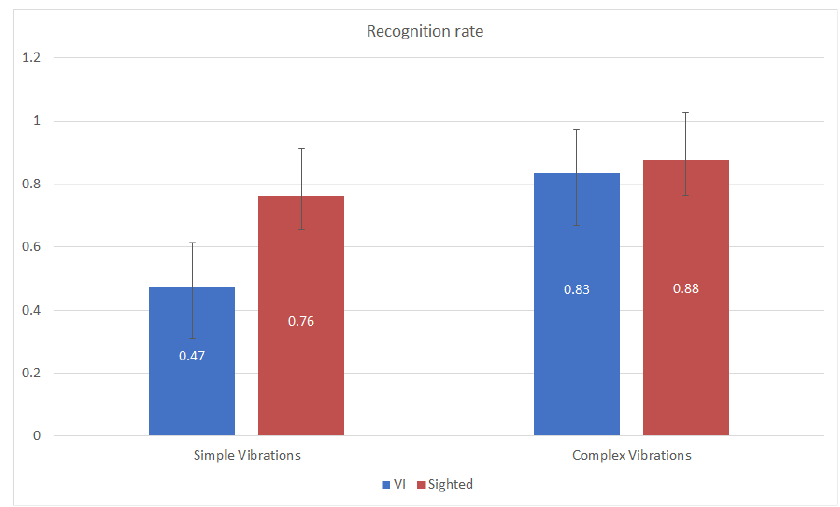
Figure 5. Application recognition rate. For all the subjects, this figure shows the recognition rate as a function of the use of simple and equal vibrations patterns or complex and different vibration patterns while differentiating between VI and sighted subjects.